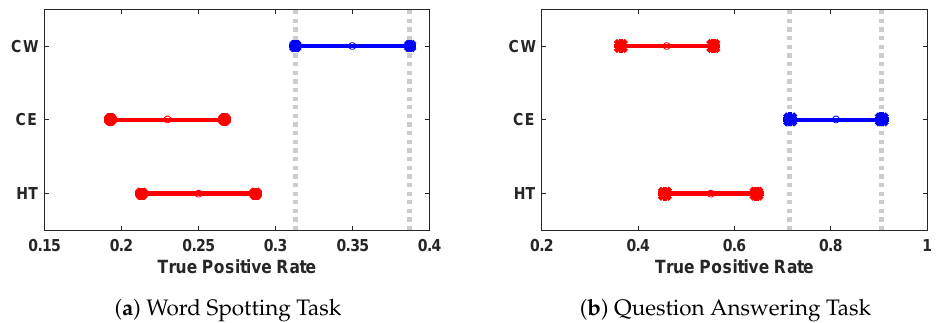
Figure 4. The figure shows the results of the post hoc analysis, both in the case of word spotting ( a ) and question answering ( b ) tasks, using the type of masker as the factor. The mean and standard deviation across all speakers for all three masking conditions are